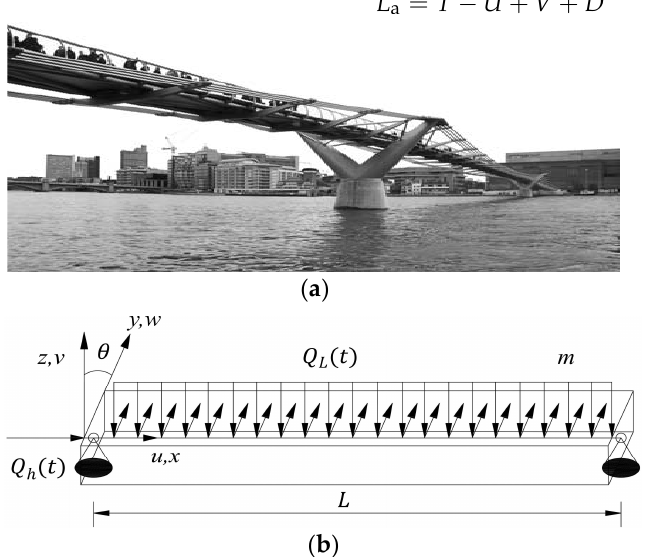
Figure 1. Physical drawing and mechanical model of simply supported STC considering longitudinal–lateral–vertical walking force. ( a ) Physical drawing. ( b ) Mechanical model.